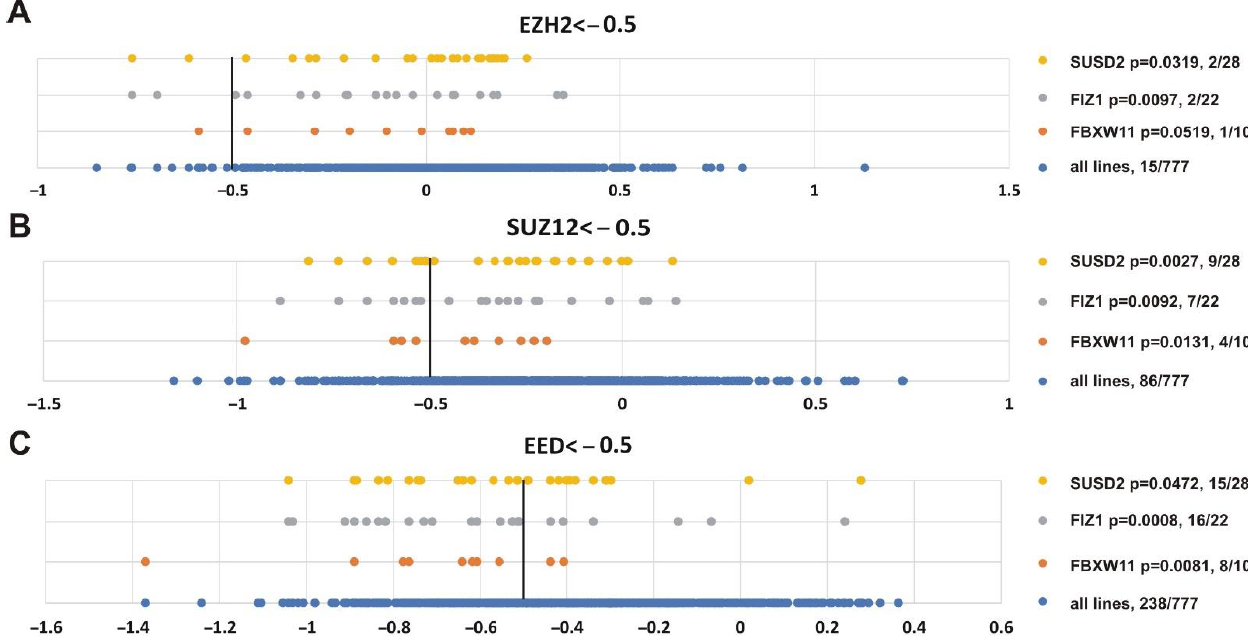
Figure 10. Genes showing significant correlation with the sensitivity of cancer cell lines to knockout of any PRC2 subunit. ( A ) EZH2 , ( B ) SUZ12 or ( C ) EED . Other designations as in Figure 8.